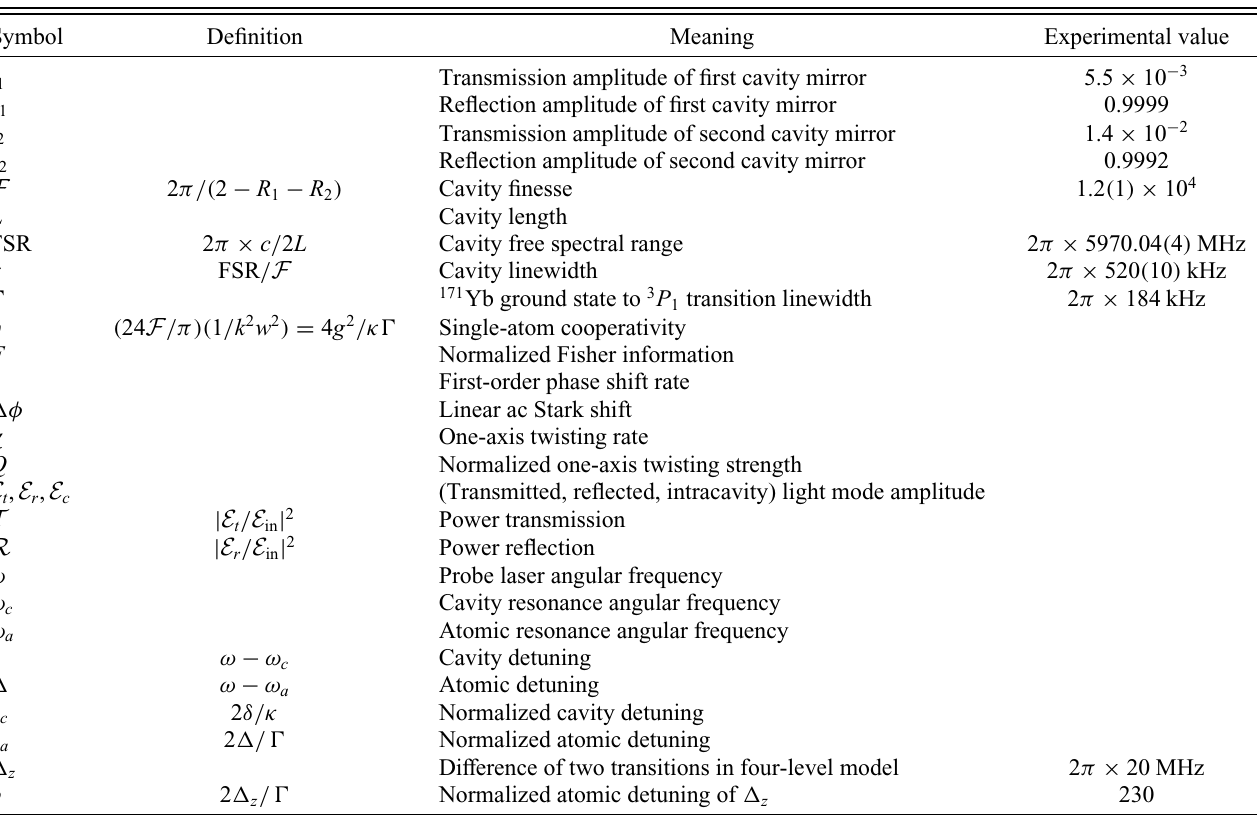
TABLE II. List of symbols used in this